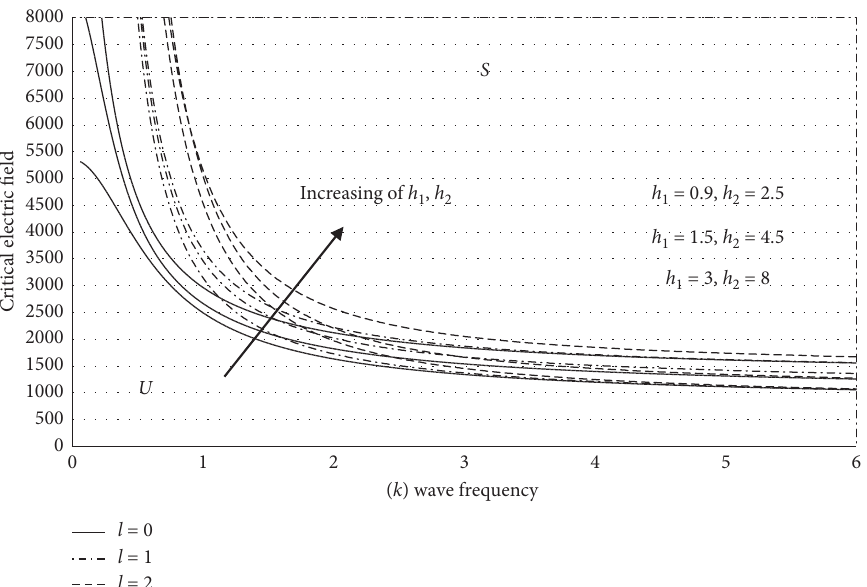
Figure 8: Variation of E 2